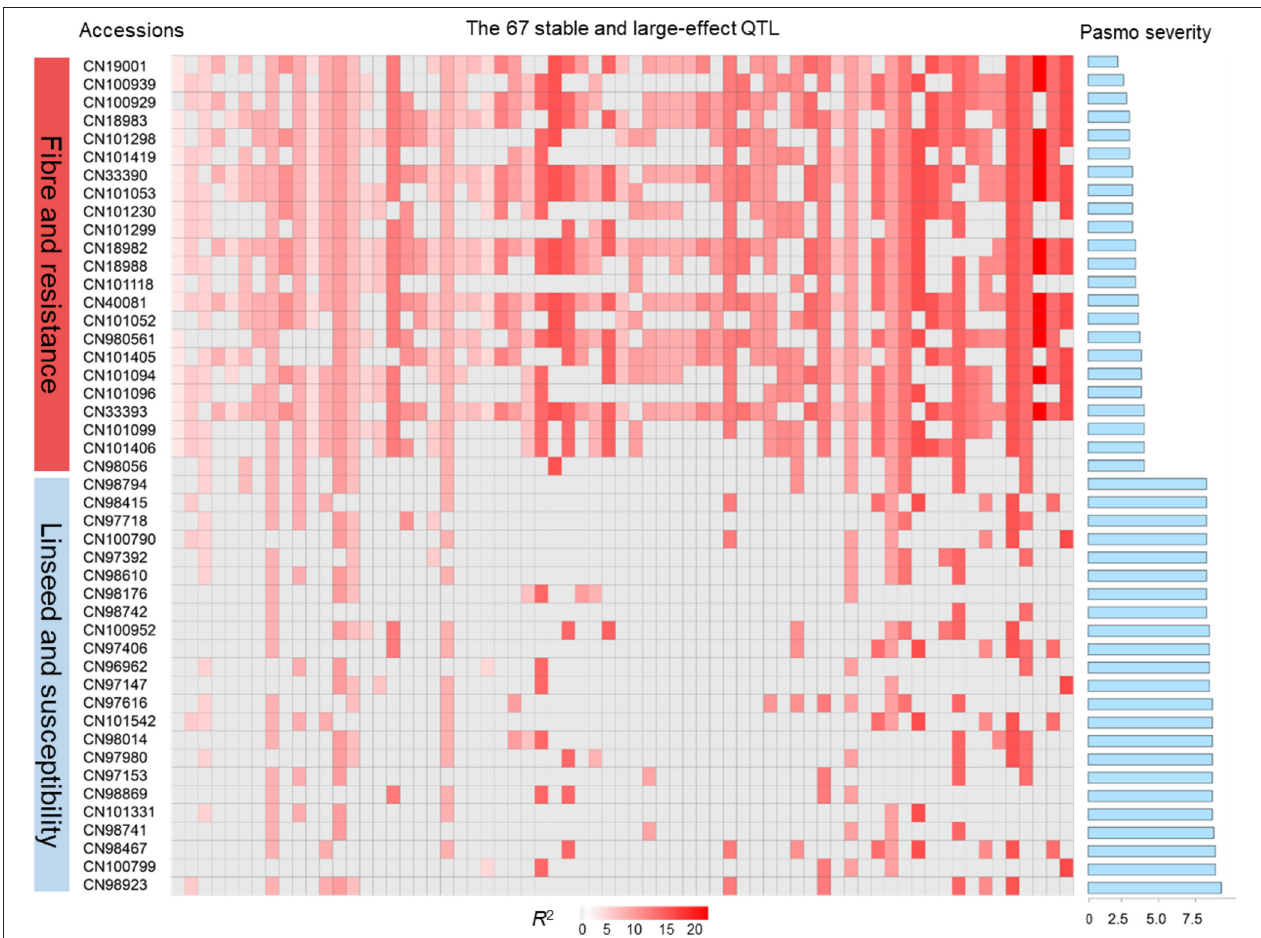
FIGURE 3 | QTL genotypes, pasmo resistance and severity, and morphotypes of two extreme subsets representing 23 resistant and 23 susceptible accessions,